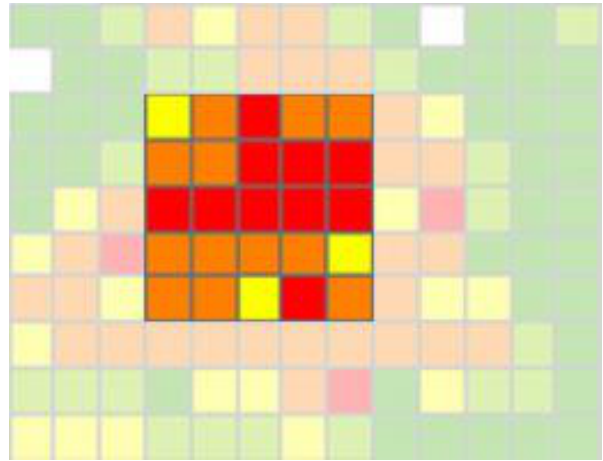
Figure 8. Experimental area.